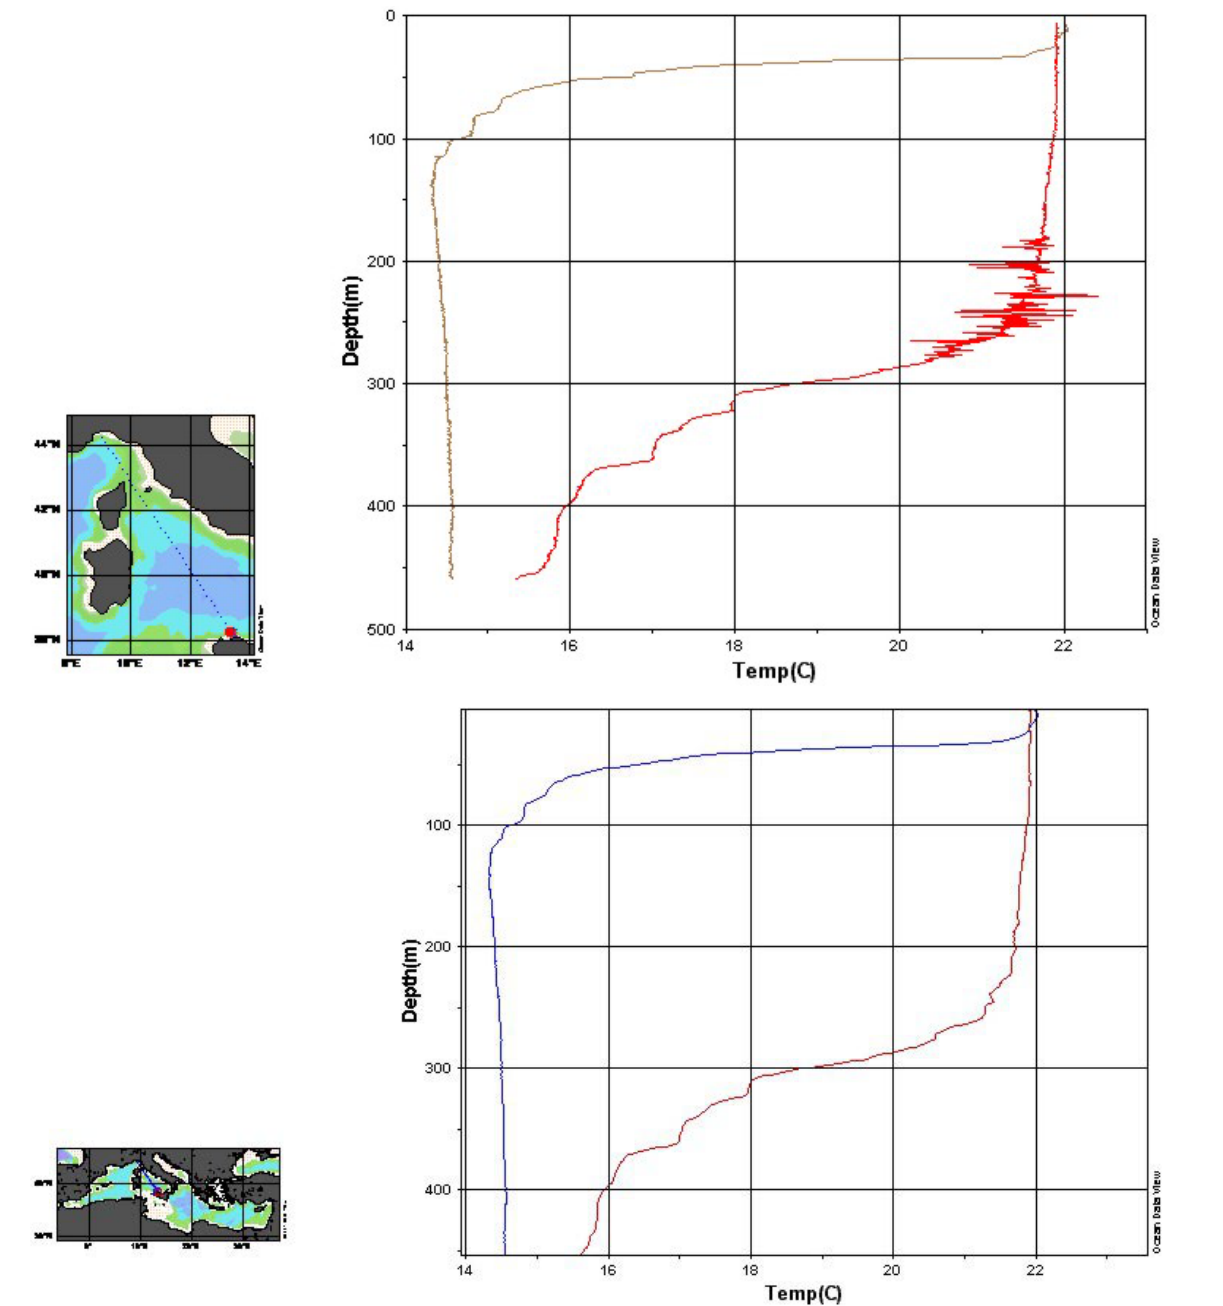
Fig. 9. Raw data showing spikes and noises (a) and the same profile after the NRT QC procedure was applied (b) .